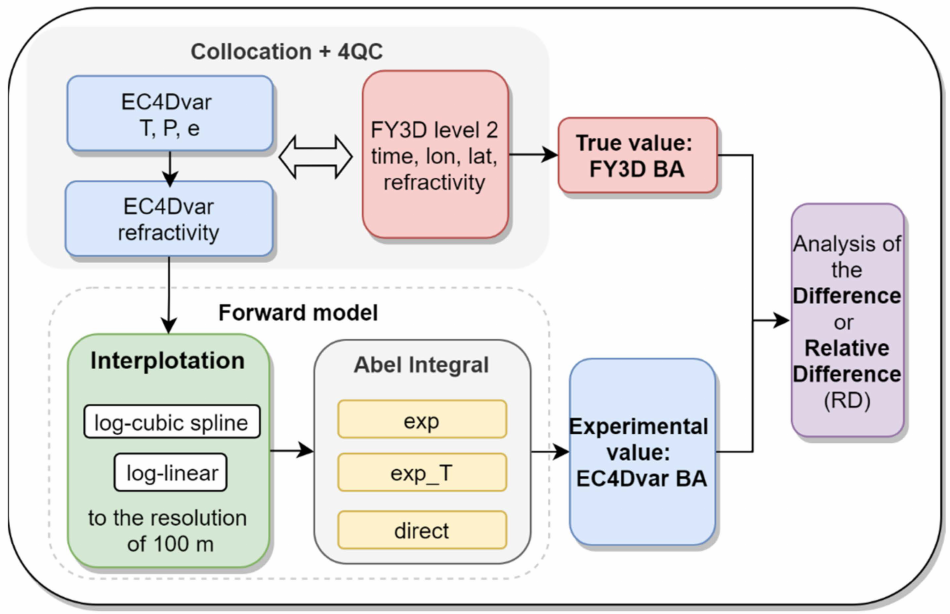
Figure 1. Flow chart for experiment 1, the algorithm